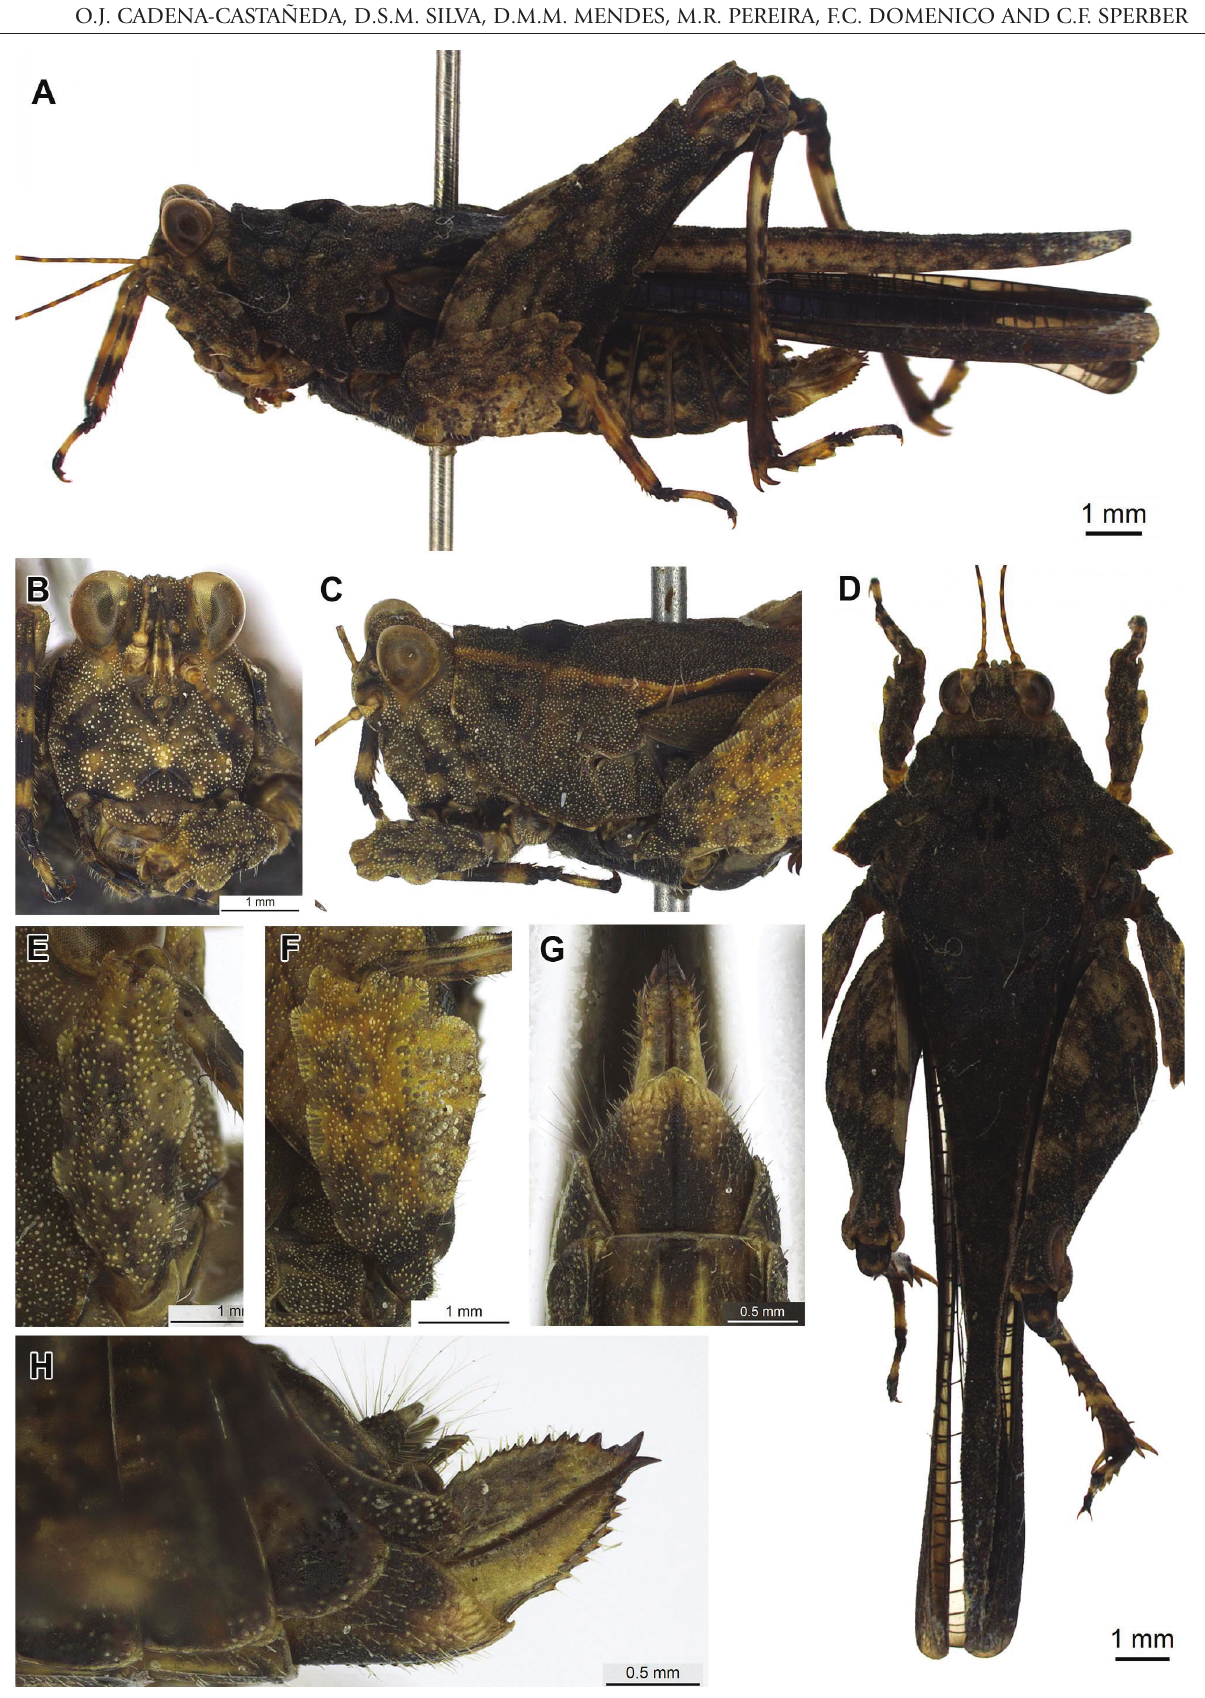
Fig. 8. Eomorphopus antennatus (female) A. Habitus in lateral view; B. Frons; C. Head, lateral lobes of pronotum and tegmina in lateral view; D. Habitus in dorsal view; E. Fore-femur; F. Mid-femur; G. Terminalia in ventral view; and H. In lateral